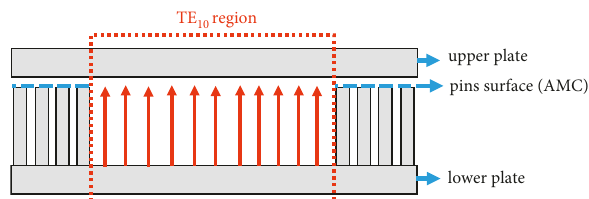
Figure 3: Geometrical diagram of the operating principle of the proposed